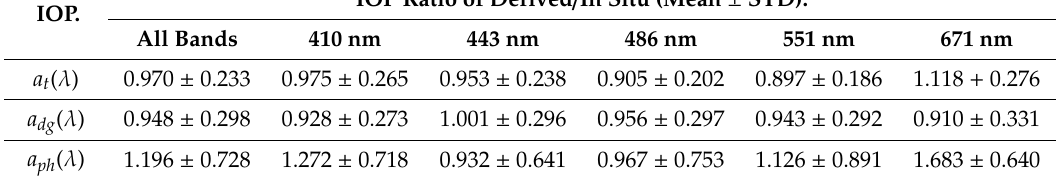
Table 2. Statistics of the ratios with standard deviation (STD) values between the derived- and in-situ-IOPs in Lake Taihu.